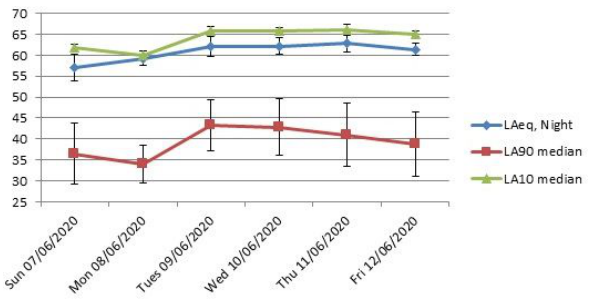
Figure 10: Case Study B: Night-time noise levels +/ − 1 standard